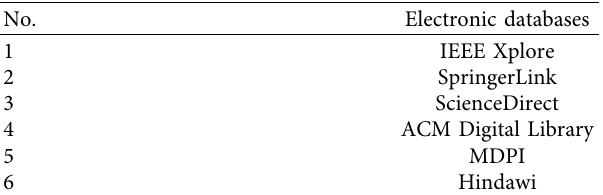
Table 1: List of electronic databases used for searching articles.